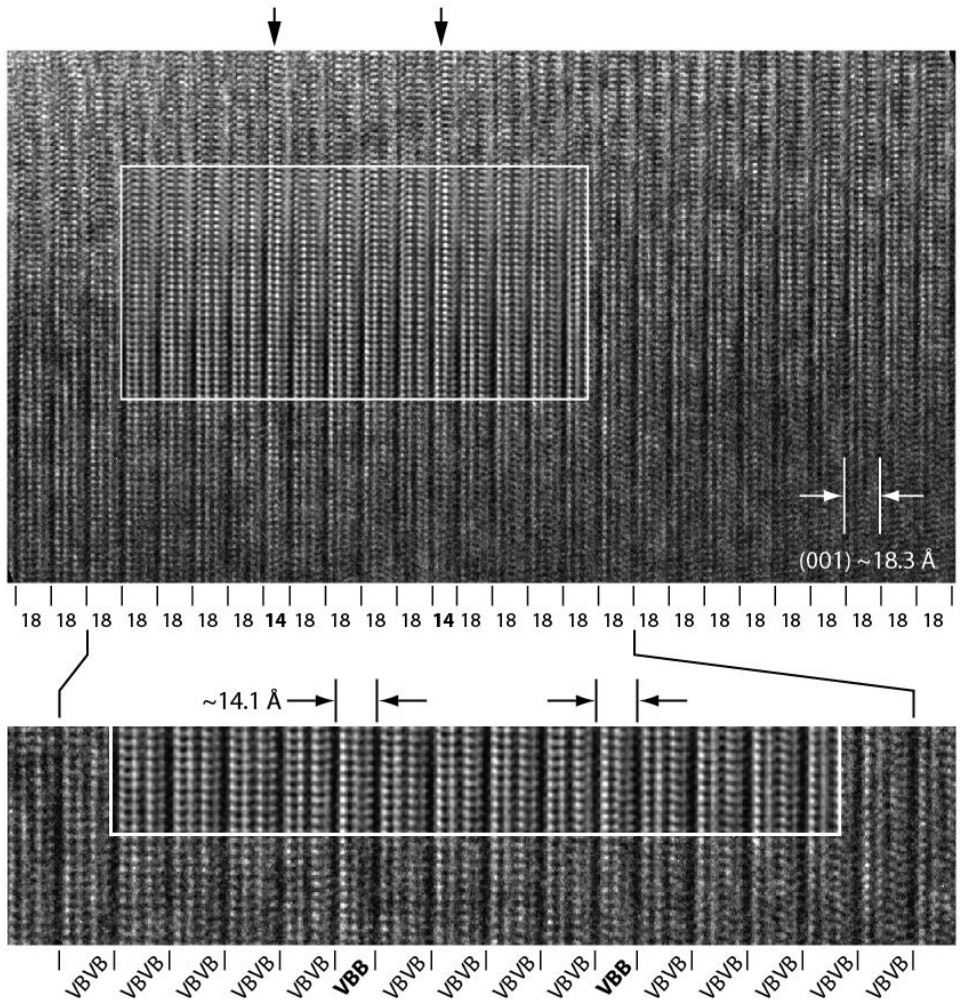
Figure 9. [100] HR image of synchysite showing two polysomatic faults (arrows). The measured width is ~14.1 Å, consistent with a single parisite half-cell with sequence VBB , within VBVB synchysite with (001) repeat distance ~18.3 Å. Inset filtered region.